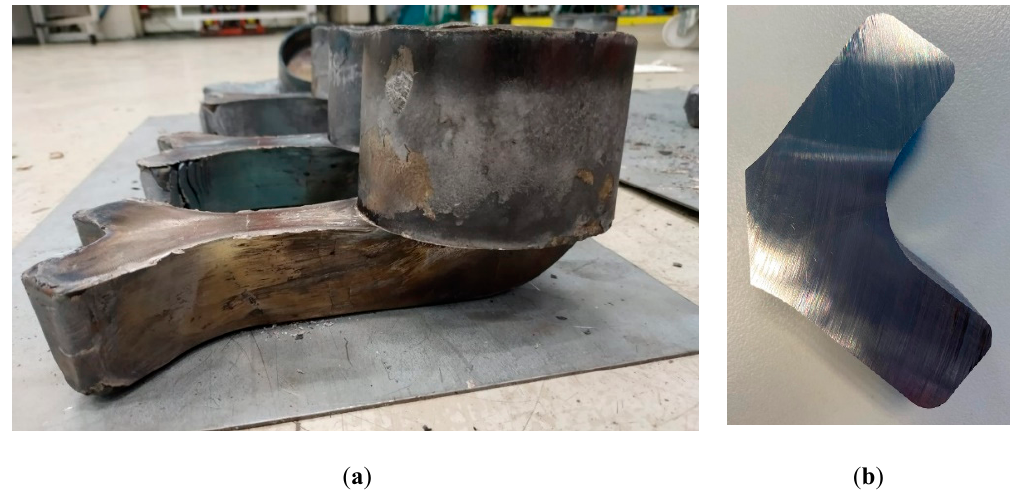
Figure 10. ( a ) Obtained component with the arm completely filled and ( b ) slice of the last filled regions.